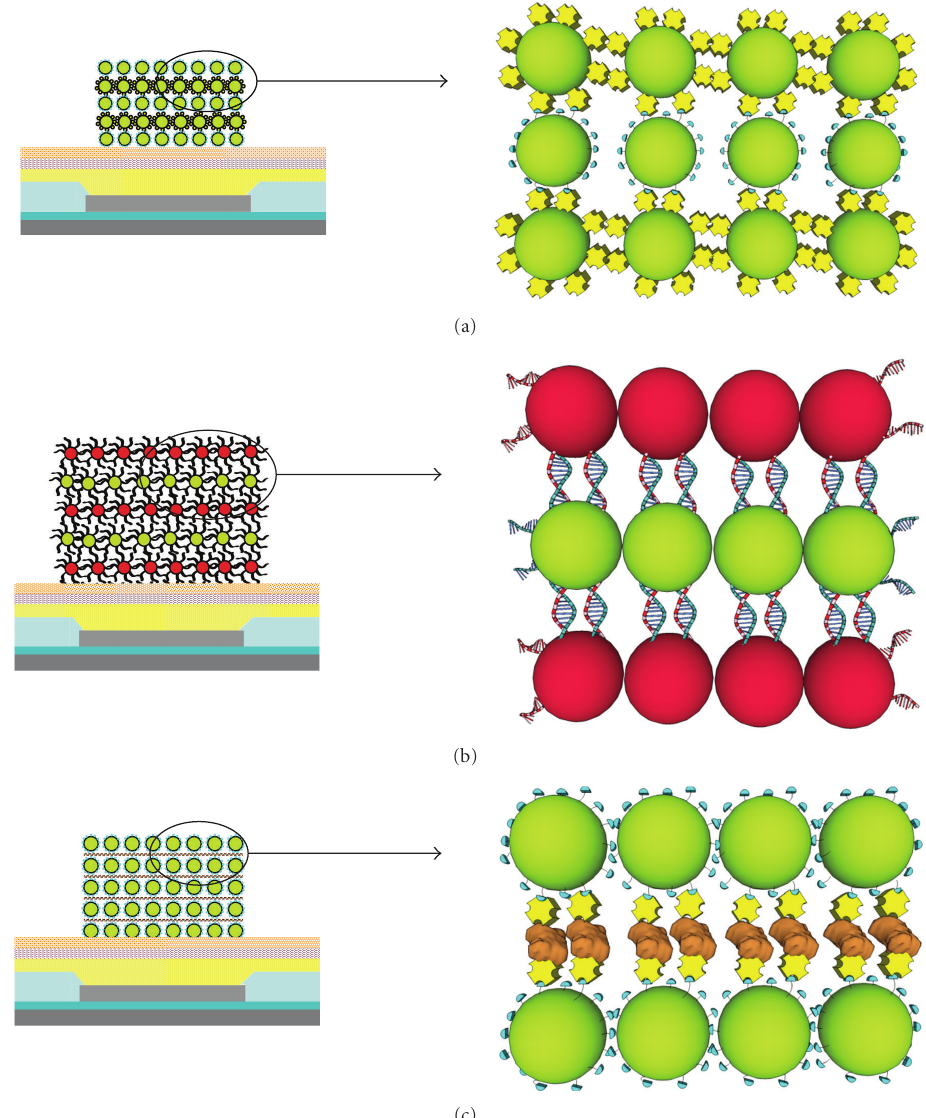
Figure 1: Electric-field-directed assembly (layering) of biomolecule NPs by di ff erent binding mechanisms: (a) NP layering with alternate biotin (blue)-functionalized NPs and streptavidin (yellow)-functionalized NPs. (b) NP layering by hybridization of complementary DNA sequences. (c) NP layering of biotin-functionalized NPs with streptavidin-functionalized enzymes (brown) (image not to scale).